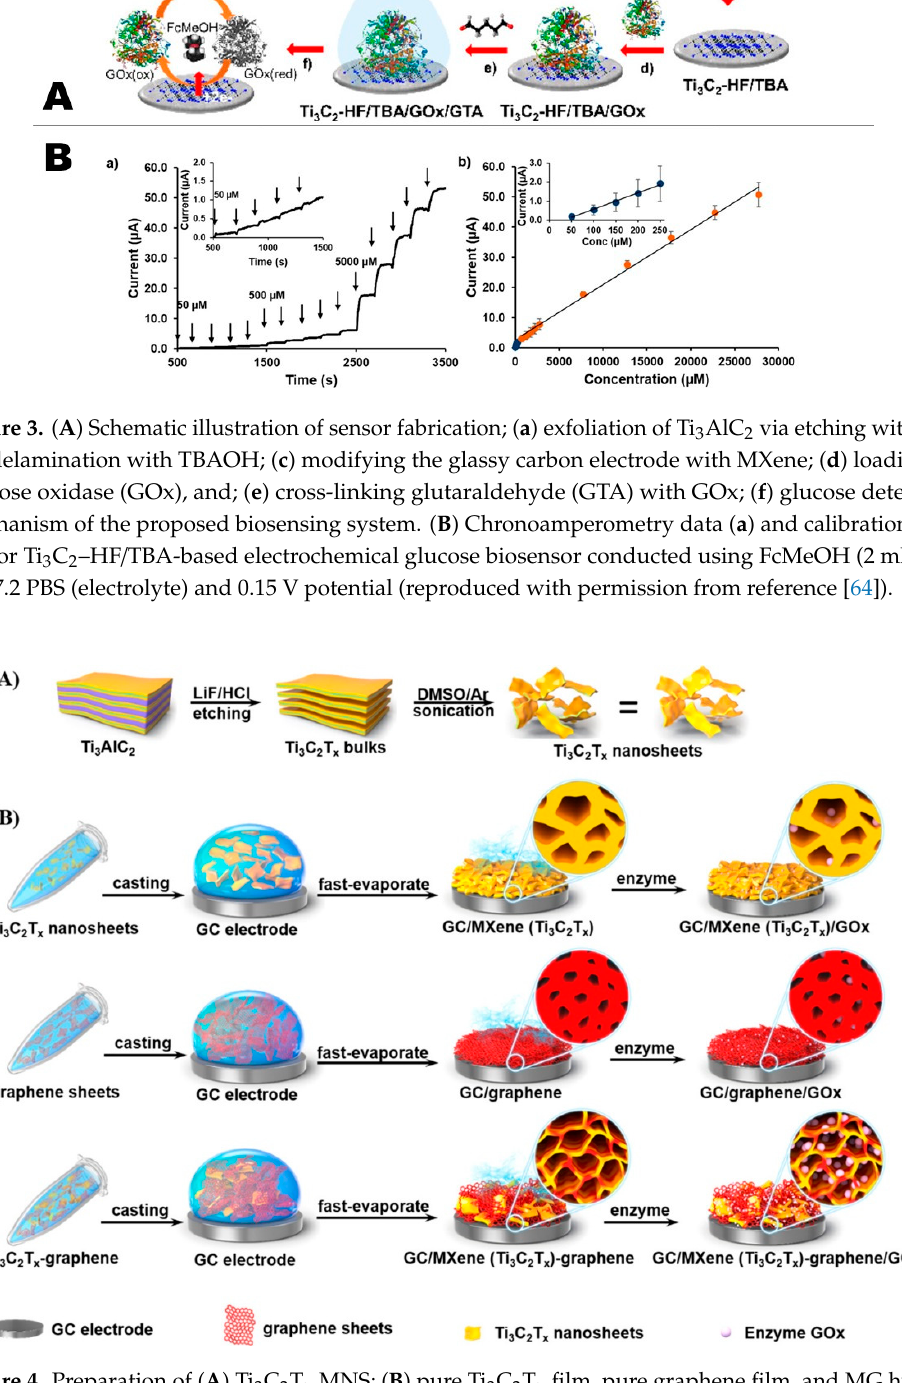
Figure 4. Preparation of ( A ) Ti 3 C 2 T x MNS; ( B ) pure Ti 3 C 2 T x film, pure graphene film, and MG hybrid film for enzyme immobilization (reproduced with permission from reference [66]).